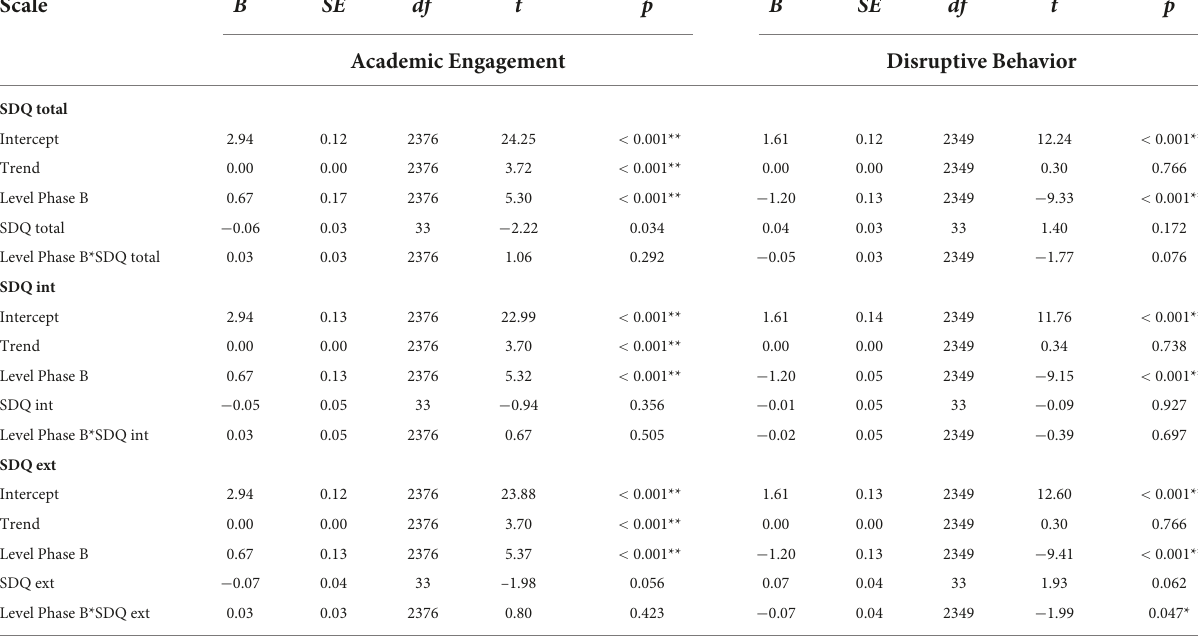
TABLE 6 Interaction of psychosocial problems with the impact of the good behavior